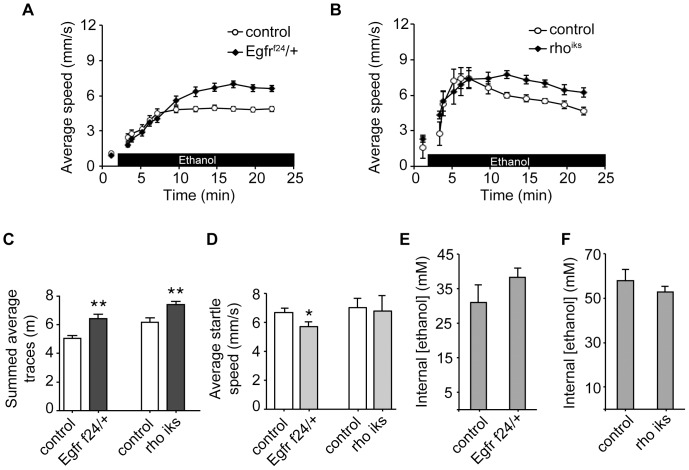
Mutations in Egfr and rho increase ethanol-induced locomotion.Ethanol-induced locomotion of (A) Egfrf24/+ and (B) rhoiks, compared to controls. First point represents baseline locomotion before ethanol exposure. (C) Area-under-curve quantification of (A) and (B). (D) Peak locomotion during ethanol-induced olfactory startle for mutant and control strains. (E) Ethanol absorption for Egfrf24/+, compared to wild-type controls. (F) Ethanol absorption after 15 minutes for rhoiks flies, compared to wild-type controls. *p<0.05, **p<0.01, Student’s T-test.